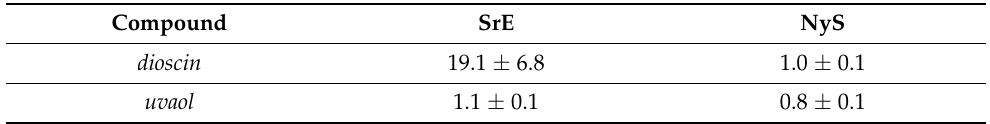
Table 4. The ratio of the transmembrane current induced by the antimycotics in the presence and absence of 50 µ M of dioscin and uvaol. The SrE modified lipid bilayers were composed of DPhPC and bathed in 0.1 M KCl (pH 7.4) and NyS-altered bilayers were formed from DPhPC/CHOL (67/33 mol%) and bathed in 2 M KCl (pH